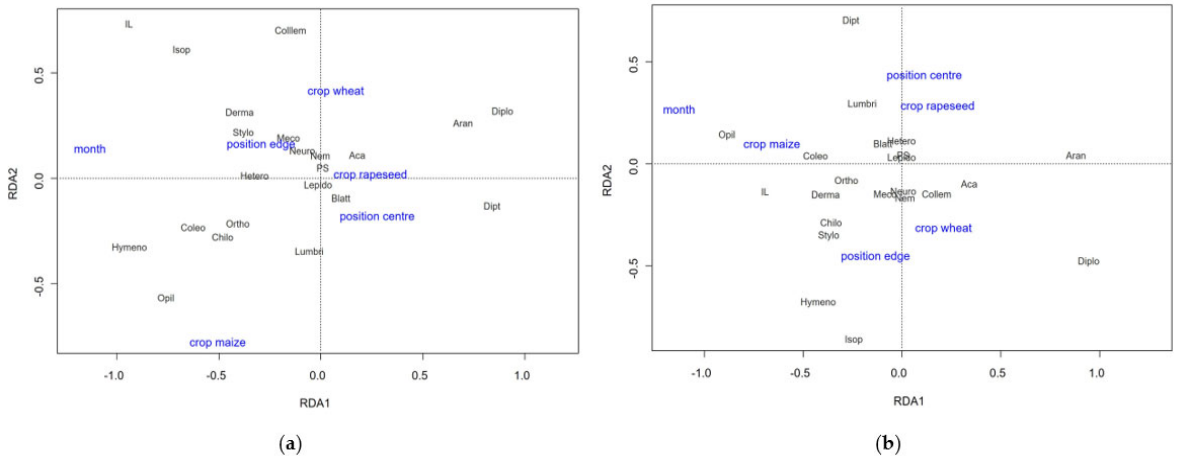
Figure 5. Results of the redundancy analyses (RDA) relating invertebrate taxonomic composition, expressed as either ( a ) abundance or ( b ) biomass, to crop type (wheat, rapeseed and maize), position within the field (edge and center) and the time of sampling within the season (month). The relationships depicted by the two most important canonical axes (RDA1 and RDA2) in the